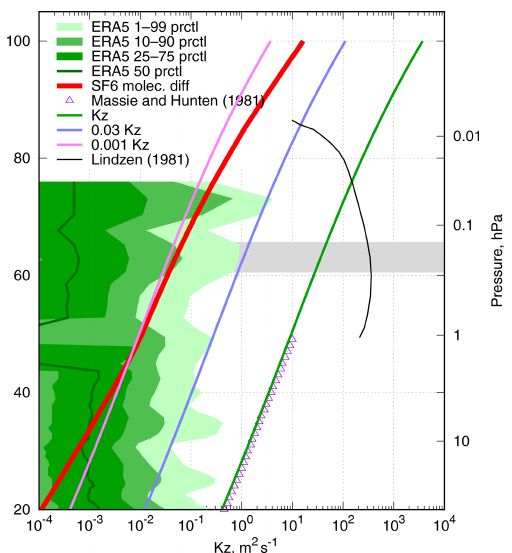
Figure 1. Vertical profiles of diffusion coefficients are shown. The distribution of the ERA5 profiles of the “mean turbulent diffusion coefficient for heat” parameter, molecular diffusivity for SF 6 in the U.S. Standard Atmosphere, and the three prescribed K z profiles are shown. The eddy diffusion profile due to breaking gravity waves (after Lindzen, 1981) is given for the